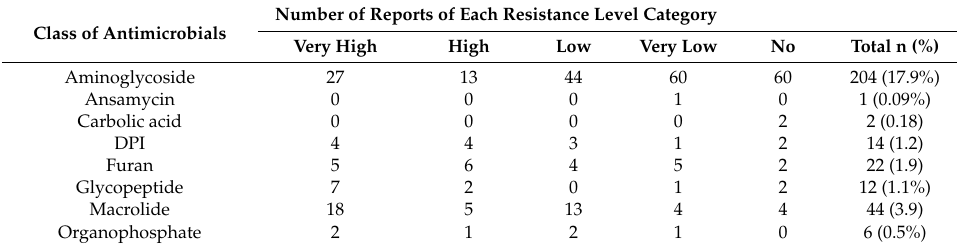
Table 4. Number of reports of each resistance level category within the classes of antimicrobial in the Antimicrobial resistance